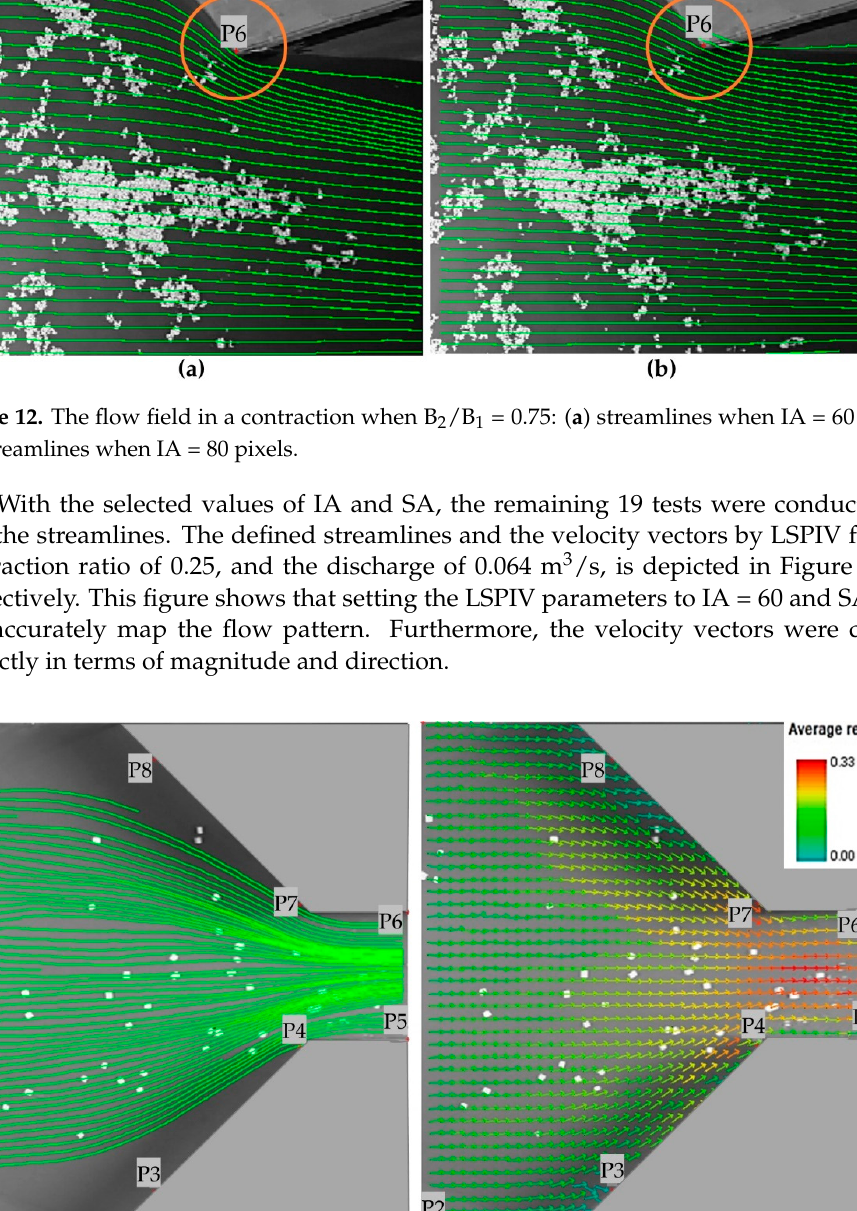
3 /s and B 2 /B 1 =